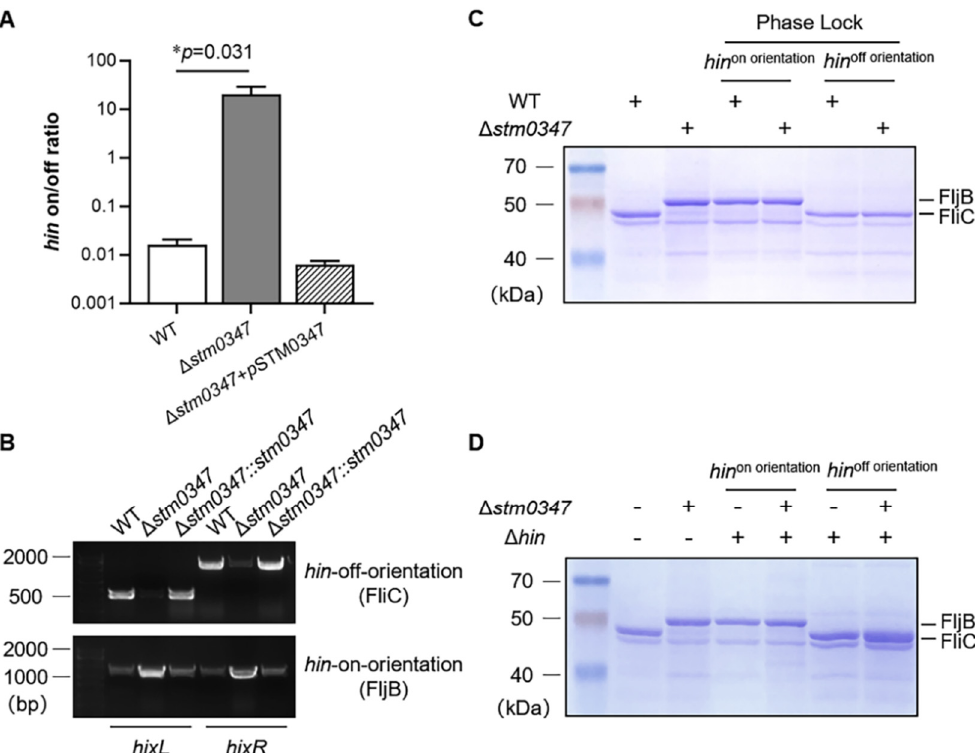
Figure 5. The alternation orientation of the hin -composed DNA segment was related to the STM0347-mediated flagella phase variation. ( A ) A real-time PCR strategy determined the ratio of fliC - and fljB -expressing DNA orientation in WT, Δ stm0347 and Δ stm0347 complemented with a STM0347-expressing plasmid induced with 0.001% arabinose. Results are presented as mean ± SD. Asterisks indicate significant differences (* p < 0.05). ( B ) Two hix sites representing the off orientation (top) or the on orientation (bottom) were PCR amplified from the genomic DNA of the WT, Δ stm0347 , Δ stm0347 chromosomally complemented with stm0347 coding sequence strains, to identify the orientation of the fliC - and fljB - expressed DNA orientation. The sizes of PCR products were listed as follows: hixL of hin -off-orientation (550 bp), hixR of hin -off-orientation (1700 bp), hixL of hin -on-orientation (1137 bp), hixR of hin -on-orientation (1113 bp). ( C ) Secreted proteins in WT, the stm0347 deletion mutant strain and four phase lock strains, was visualized with Coomassie blue strained gel. ( D ) Secreted proteins in WT, the stm0347 deletion mutant strain and four hin deletion mutant strains, were visualized with Coomassie blue strained gel.